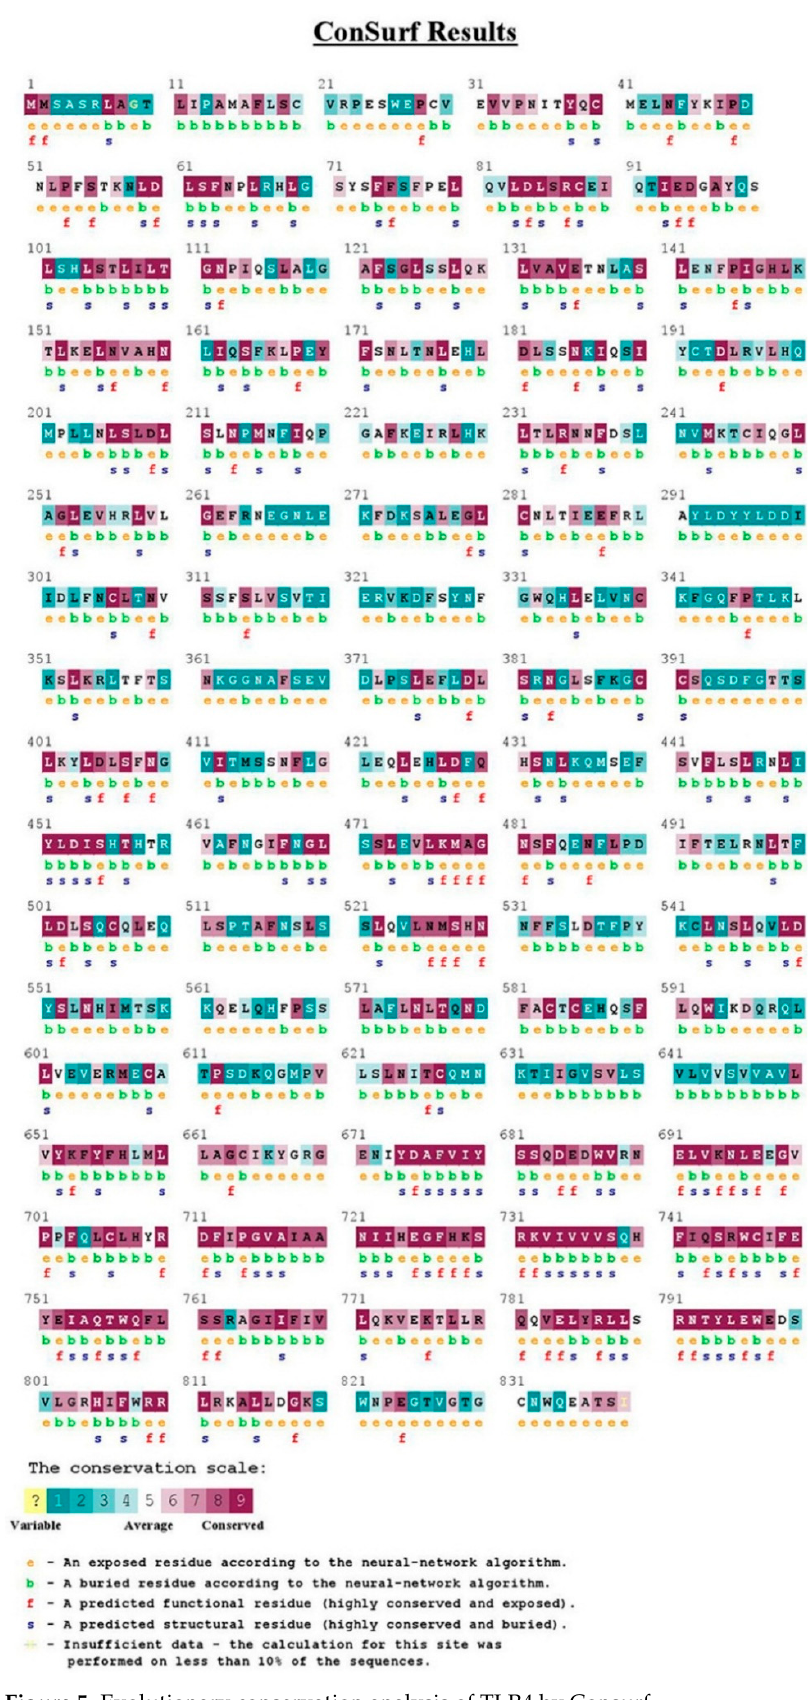
Figure 5. Evolutionary conservation analysis of TLR4 by Consurf.